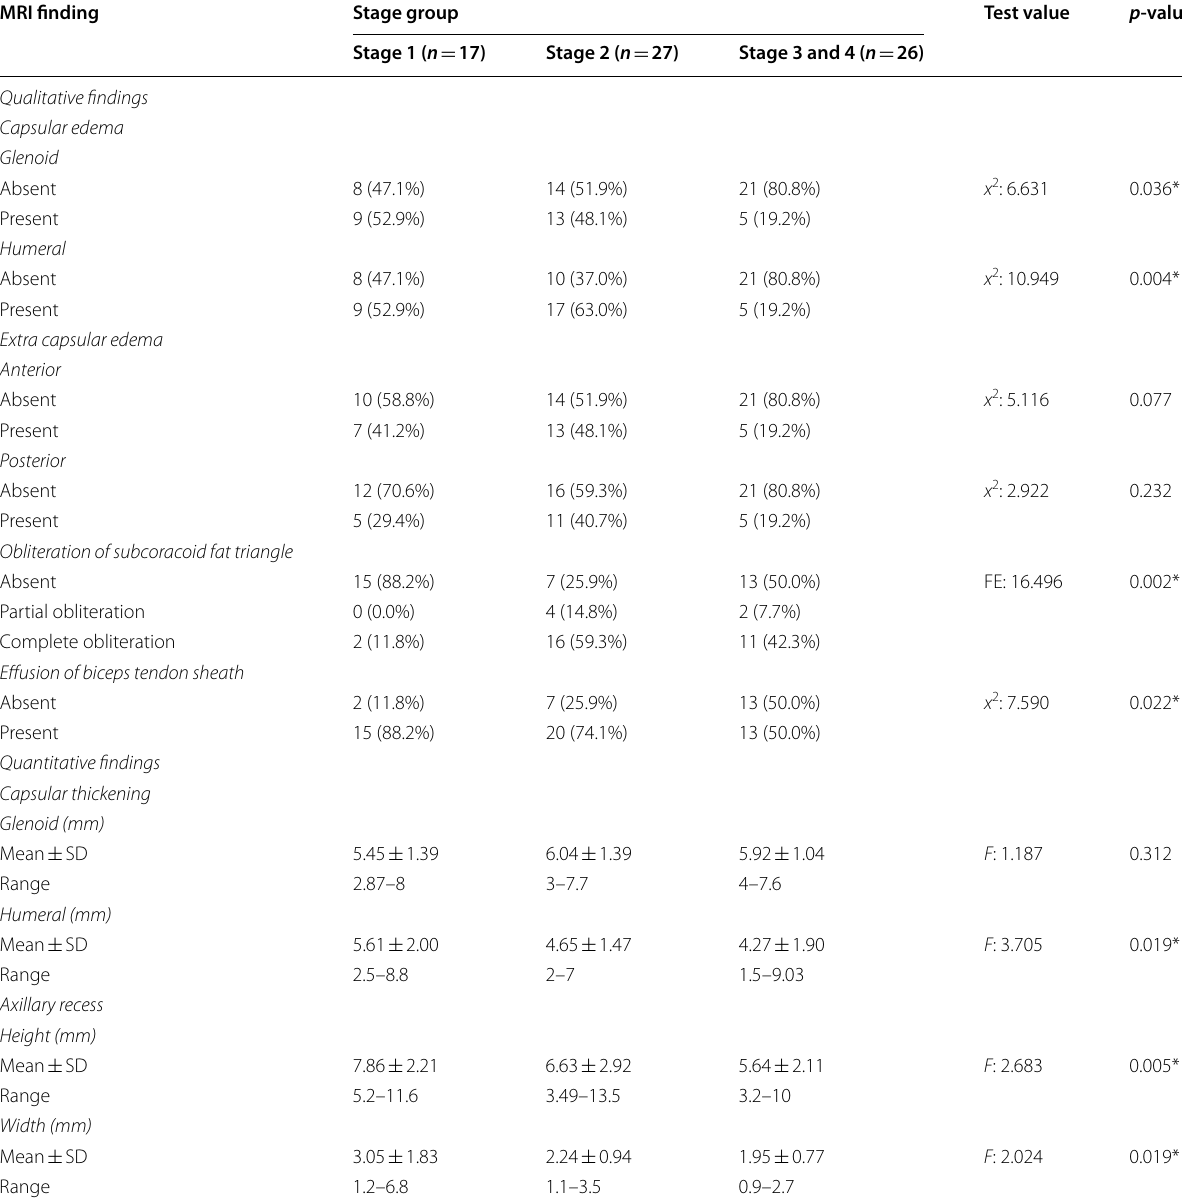
Table 8 Association between clinical stage according to MRI finding ( n